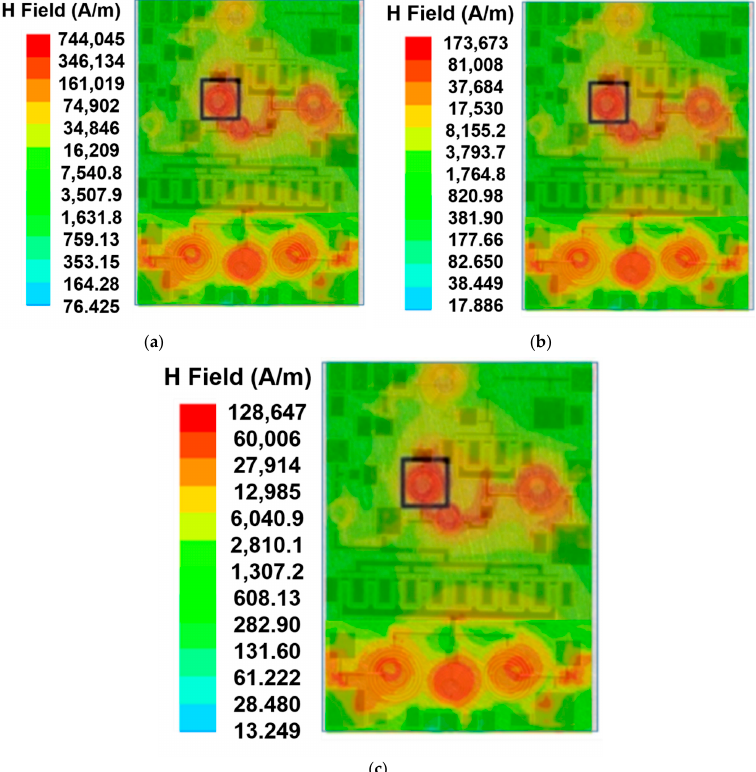
Figure 10. Maximum magnetic field strength at the surface of top IC with different vertical separation between the dies in a stack of 3D-IC with two layers. The vertical separation is as follows: ( a ) 0 μ m, ( b ) 50 μ m, and ( c ) 300 μ m, respectively, and the operating frequency is 3 GHz. Appl. Sci. 2019 , 9 , x FOR PEER REVIEW